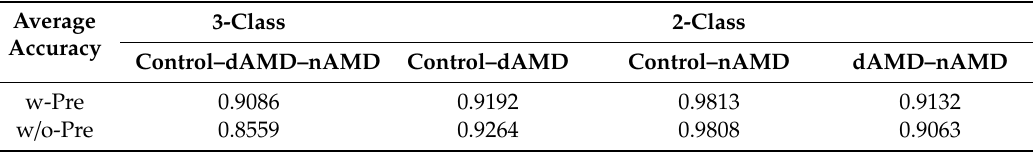
Table 1. Comparison of outcomes according to preprocessing.